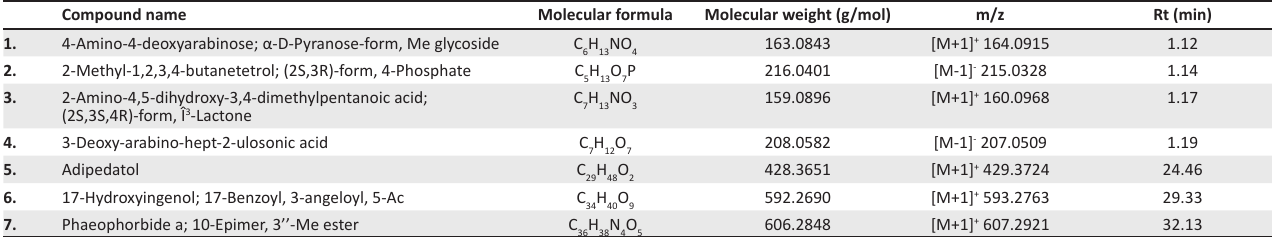
TABLE 1: Putatively identified compounds in Alchornea laxiflora .